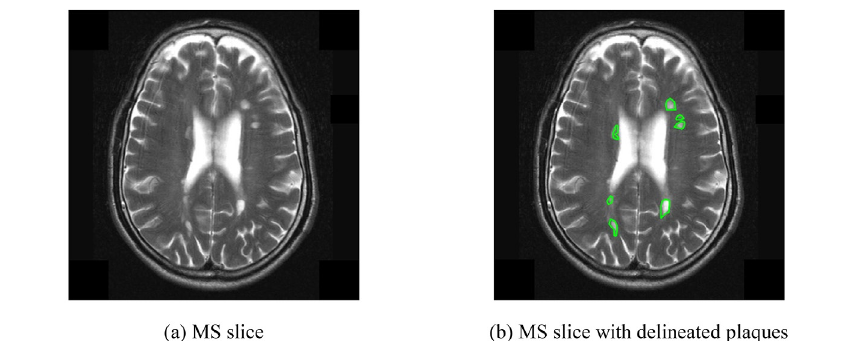
Figure 1. Samples of our dataset.